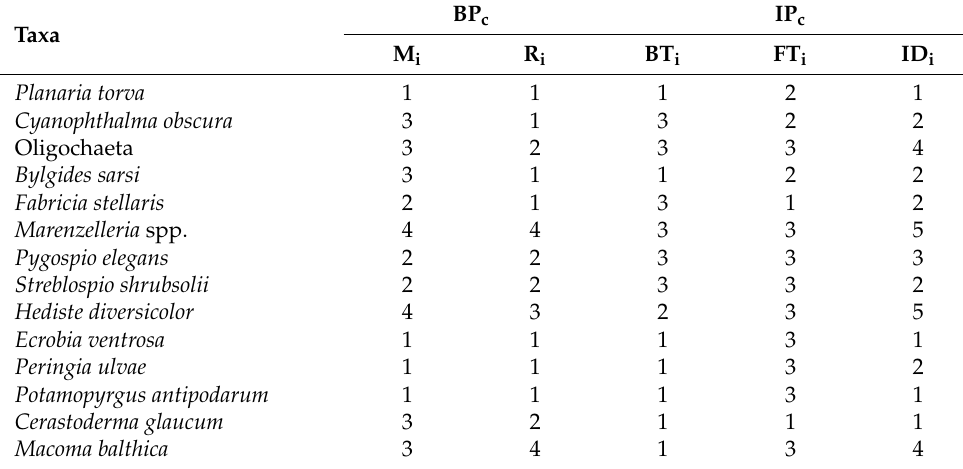
Table A1. Categorical scores assigned to each taxon for BP c and IP c indices calculations according